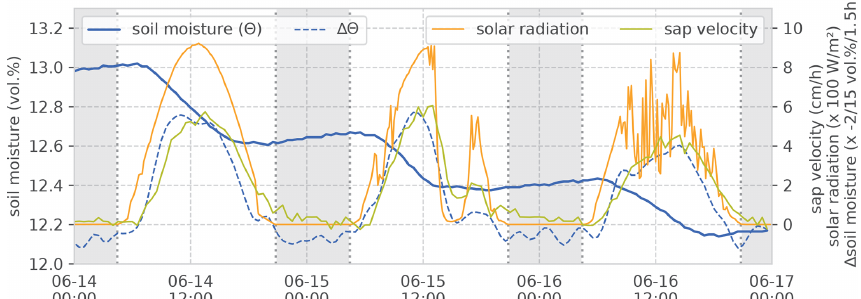
Figure 3. Example of observed soil moisture, sap velocity and solar radiation during 3d in the vegetation period. The example is from the sand site data set; soil moisture values are at a 0.7m depth. The weather for 14 June is sunny with clear-sky conditions, 15 June has a clear sky with one overcast spell in the afternoon and 16 June is a day with fair weather and radiation noise by scattered cumulus clouds. Shading refers to astronomical night time. Note that the change in soil moisture is inverted in the plot for easier comparison with sap velocity and radiation.